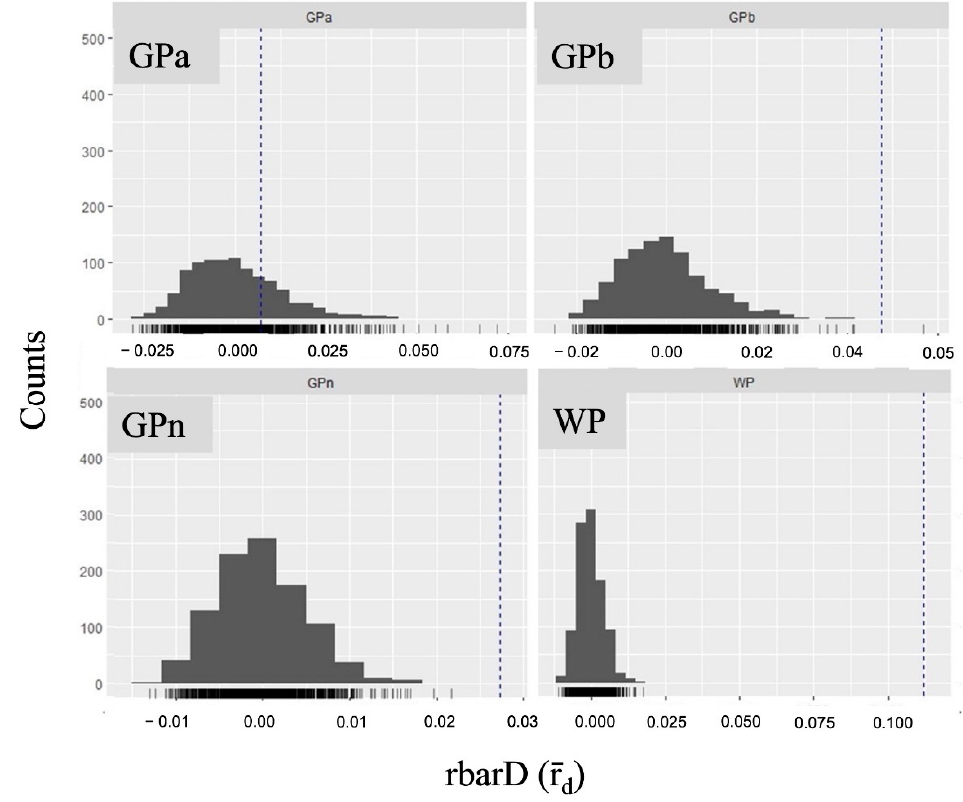
Figure 2. The standardized index of association, rbarD (r ̄ d), of four N. shimadai populations in northern Taiwan. Vertical dashed lines determine statistical significance ( p = 0.05) for linkage disequilibrium. Only the GPa population is under panmixia as it is not significant to LD. The other three populations showed evidence of LD ( p < 0.05). Table 2. Analysis of molecular variance (AMOVA) of N. shimadai populations in northern Taiwan using 39 SSR